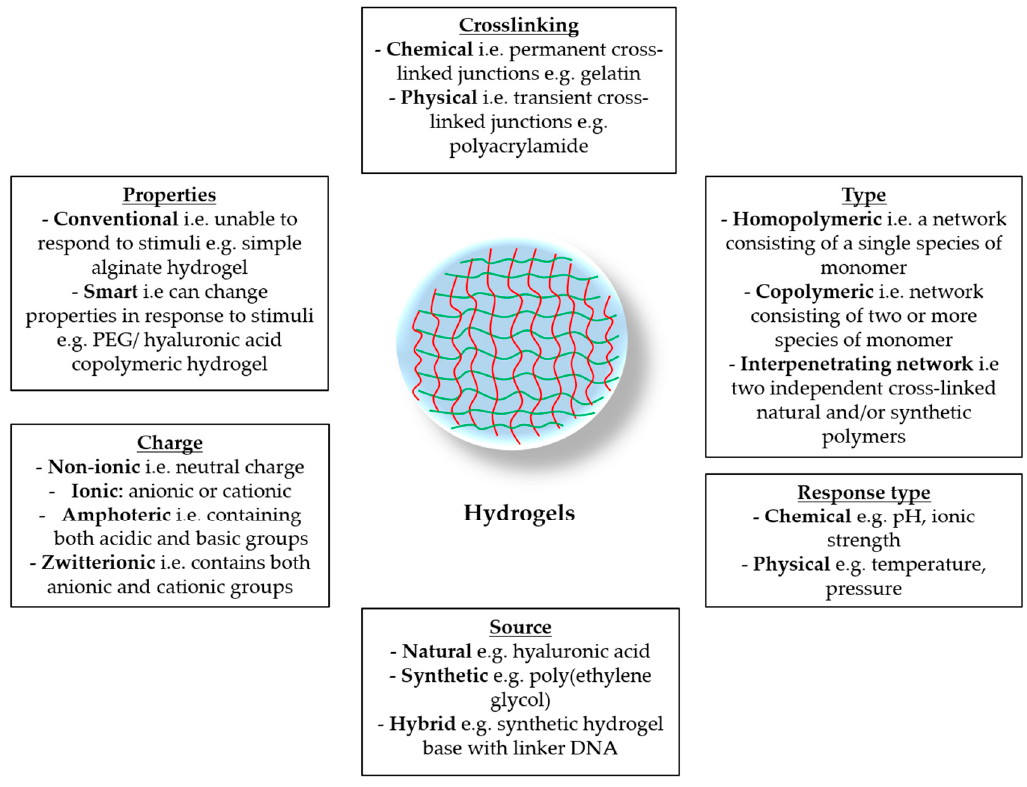
Figure 2. The various parameters by which hydrogels are classified.